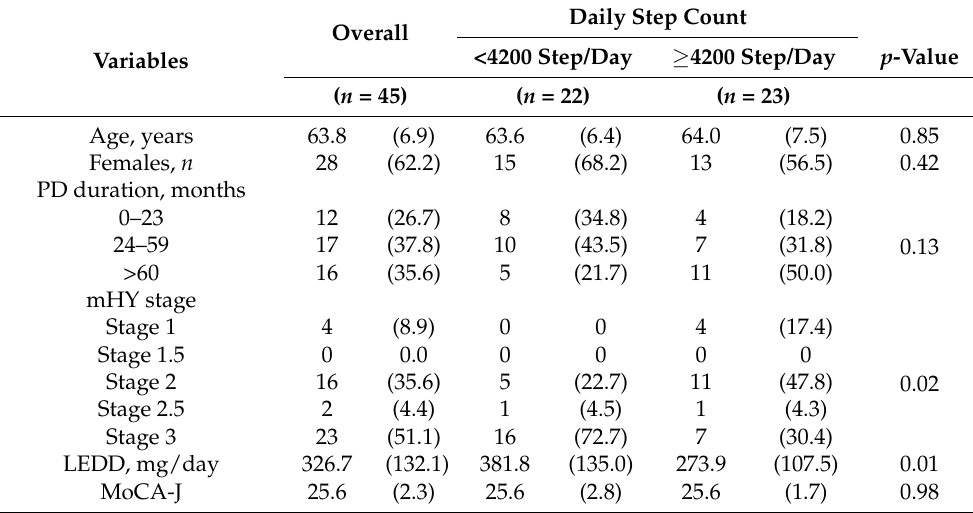
Table 1. Demographic and clinical characteristics of the study